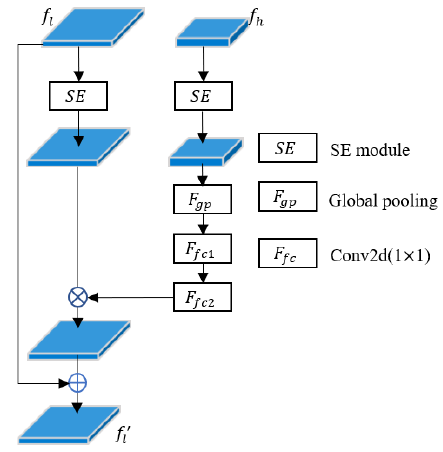
Figure 5. Co-layer aggregation module.